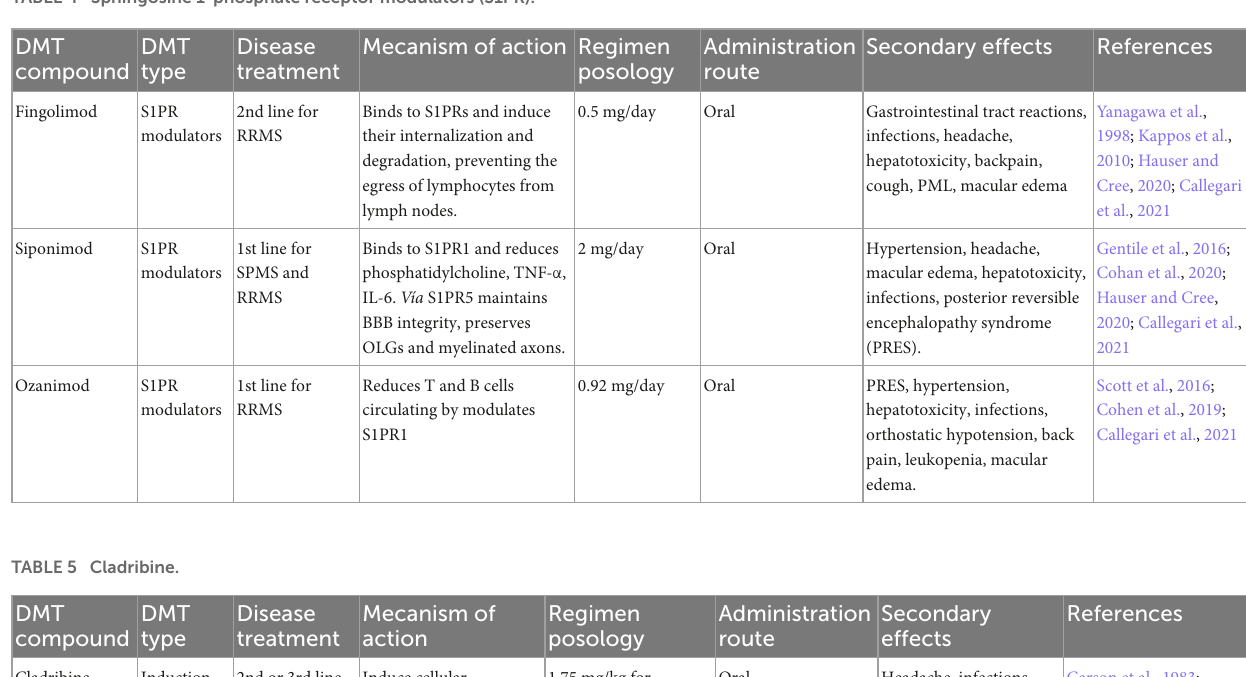
TABLE 4 Sphingosine 1-phosphate receptor modulators